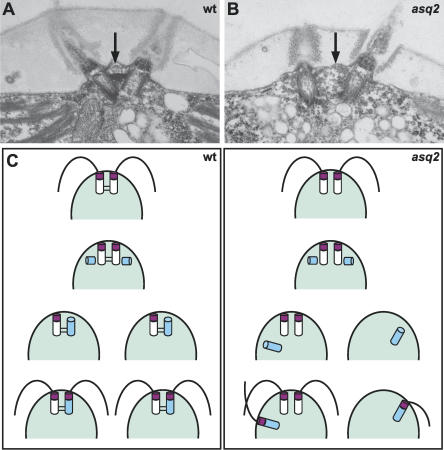
Using asq2 Cells to Test the Role of the Mother Centriole(A) Electron micrograph showing electron-dense connecting fibers (distal striated fiber, denoted by arrow) joining mother and daughter centrioles.(B) Electron micrographs of asq2 cell showing that centriole connecting fibers are missing.(C) Model for centriole positioning by mother centriole. In wt cells (left box), two centrioles are localized to the apical pole. These centrioles are connected by electron-dense connecting fibers (see [A], arrow). During duplication, each centriole will serve as a mother (white) to give rise to a daughter centriole (blue). New connections will form between each new mother–daughter pair. One mother–daughter centriole pair will be segregated to each cell following cell division. Each centriole will give rise to a flagellum, resulting in two cells with two centrioles and two flagella. In asq2 cells (right box), centrioles are no longer connected (see [B], arrow). As in wt cells, each centriole will serve as a mother (white) to give rise to a daughter centriole (blue). However, because mother and daughter centrioles are no longer connected, centrioles will not segregate properly following mitosis, resulting in cells with variable numbers of centrioles. Among the centrioles that are distributed between cells, there will be a mix of mother and daughter centrioles. If the mother centrioles contain the necessary mark (purple) that allows them to find their proper subcellular location, whereas daughter centrioles are naive and unable to track to the correct place in the cell, then cells will have a population of properly positioned mother centrioles and a population of randomly localized daughter centrioles.